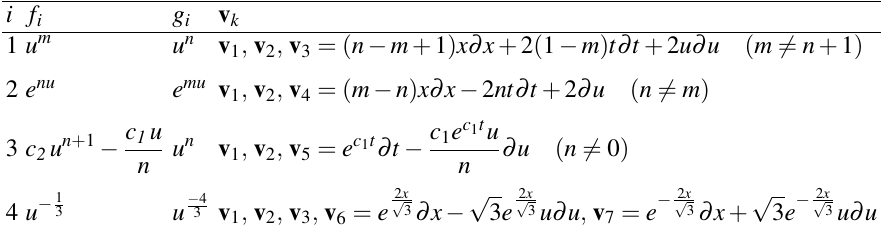
Table 1: Functions and generators.